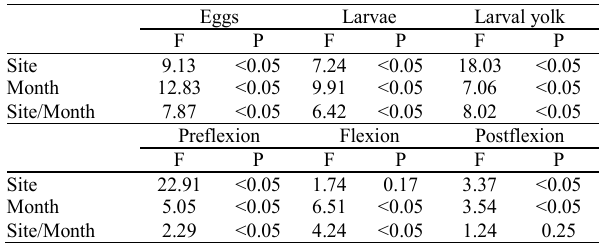
Table 3. Resuts of the two-way ANOVA applied to the total density of eggs and larvae and to the different larval stages found in three sampling sites of the Ligeiro River (rapids, pool and mouth) from September 2006 through March 2007. P-value < 0.05 indicates significant statistical